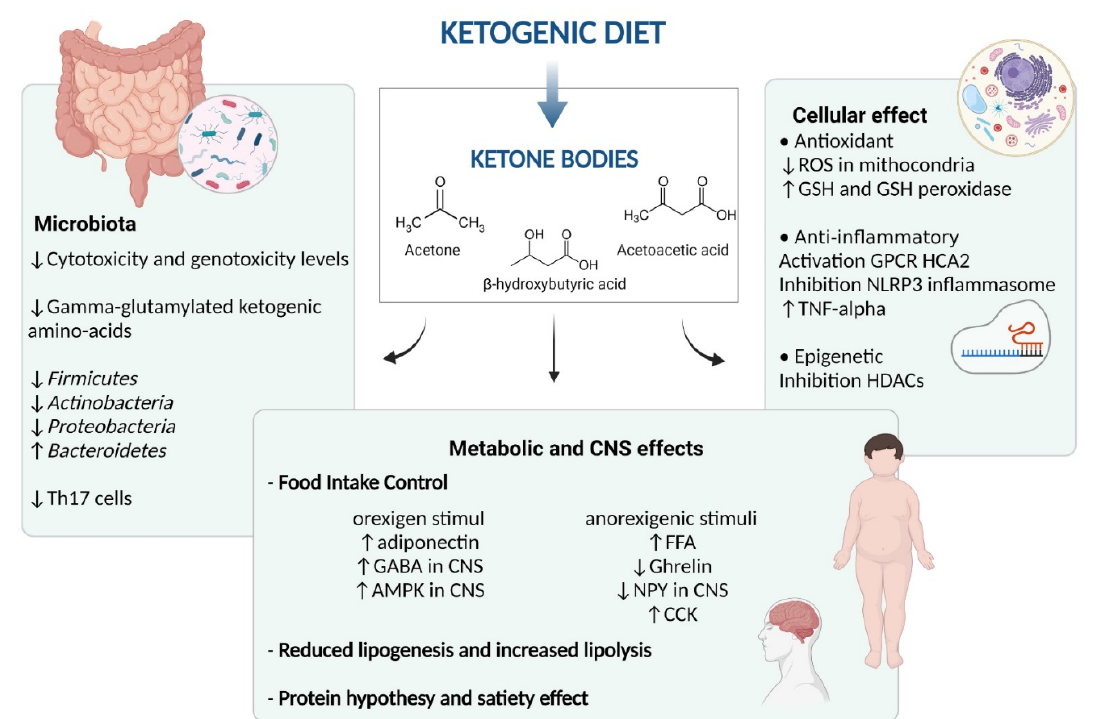
Figure 3. Mechanisms of ketogenic diet action. ROS = reactive oxygen species; GABA = gamma-aminobutyric acid; GSH = glutathione; G-protein-coupled receptor (GPCR); HCA2 = hydroxycarboxylic acid receptor 2; HDAC = histone deacetylase; Th = T helper; TNF- α = tumor necrosis factor alpha; NPY = neuropeptide Y; CCK = cholecystokinin; CNS = central nervous system; AMPK = AMP-activated protein kinase.